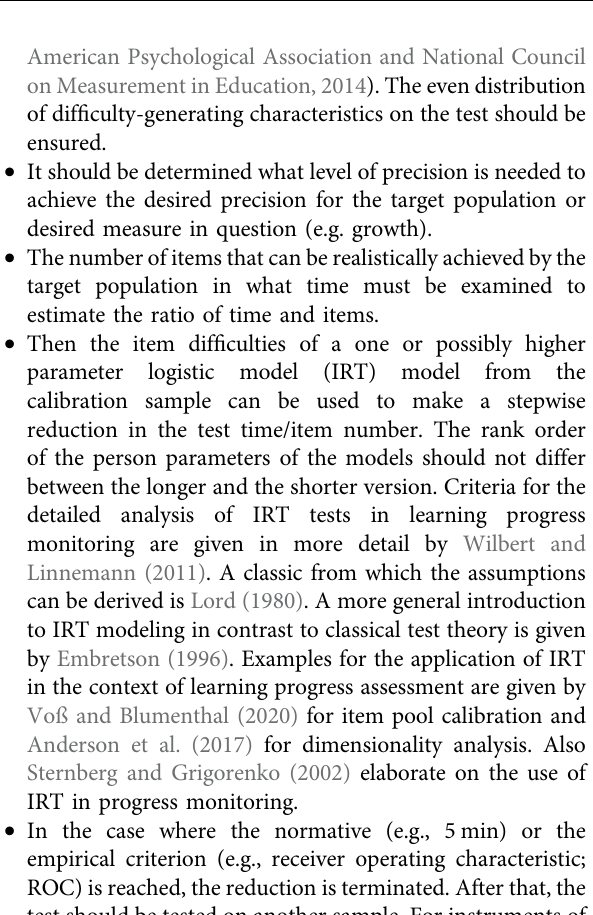
FIGURE 6 | WLE Reliability by duration of the